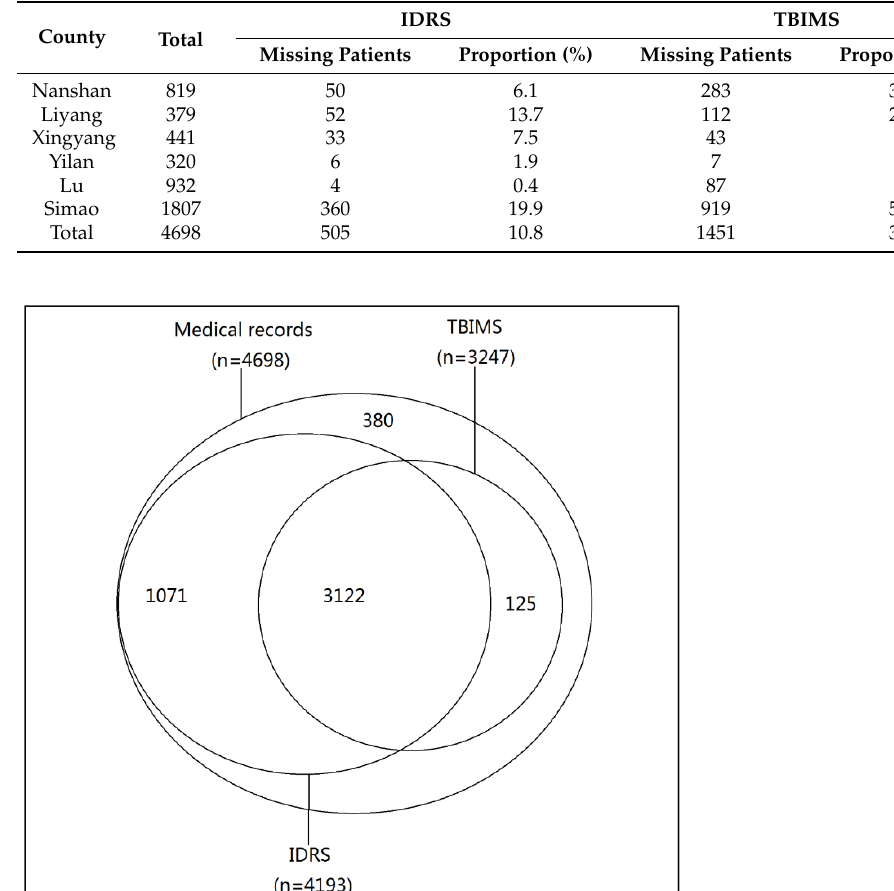
Figure 1. The distribution of TB patients from medical records, IDRS, and TBIMS in the six counties in